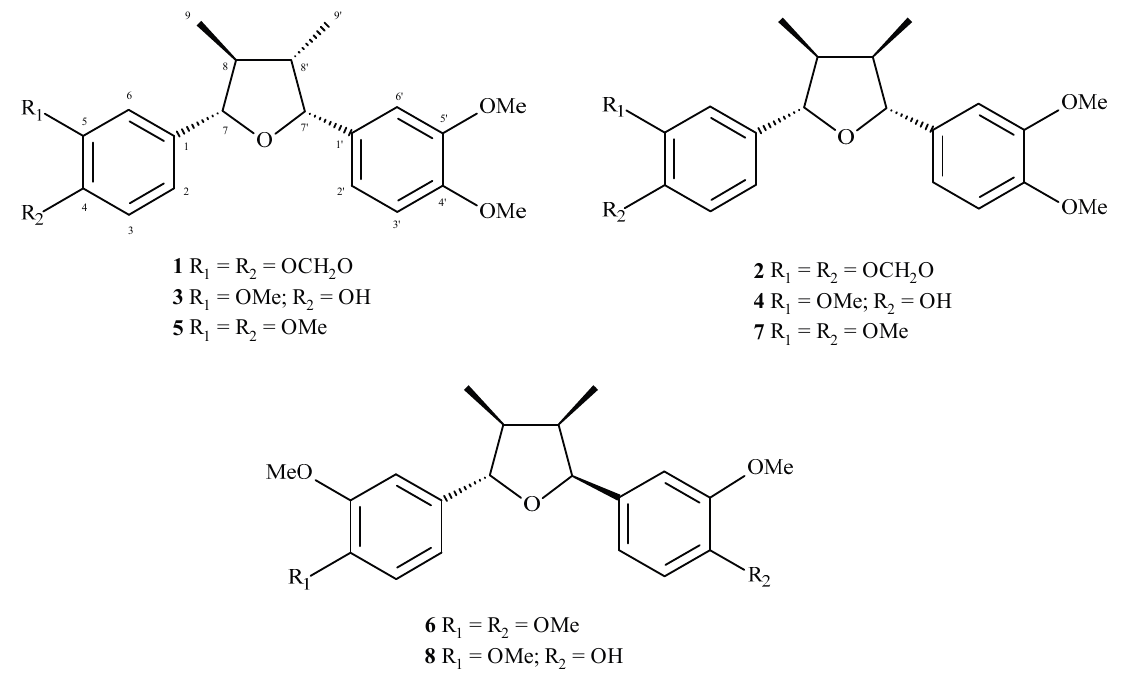
Figure 1. Tetrahydrofuran neolignans 1 – 8 isolated from the leaves of N. megapotamica .